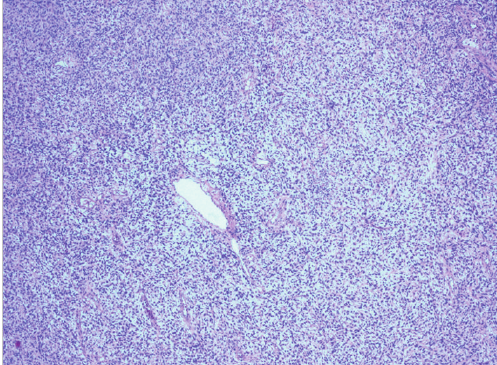
Figure 2: Low-power field histopathology shows undi ff erentiated spindle cell sarcoma with bland spindled cells arranged in short fascicles.